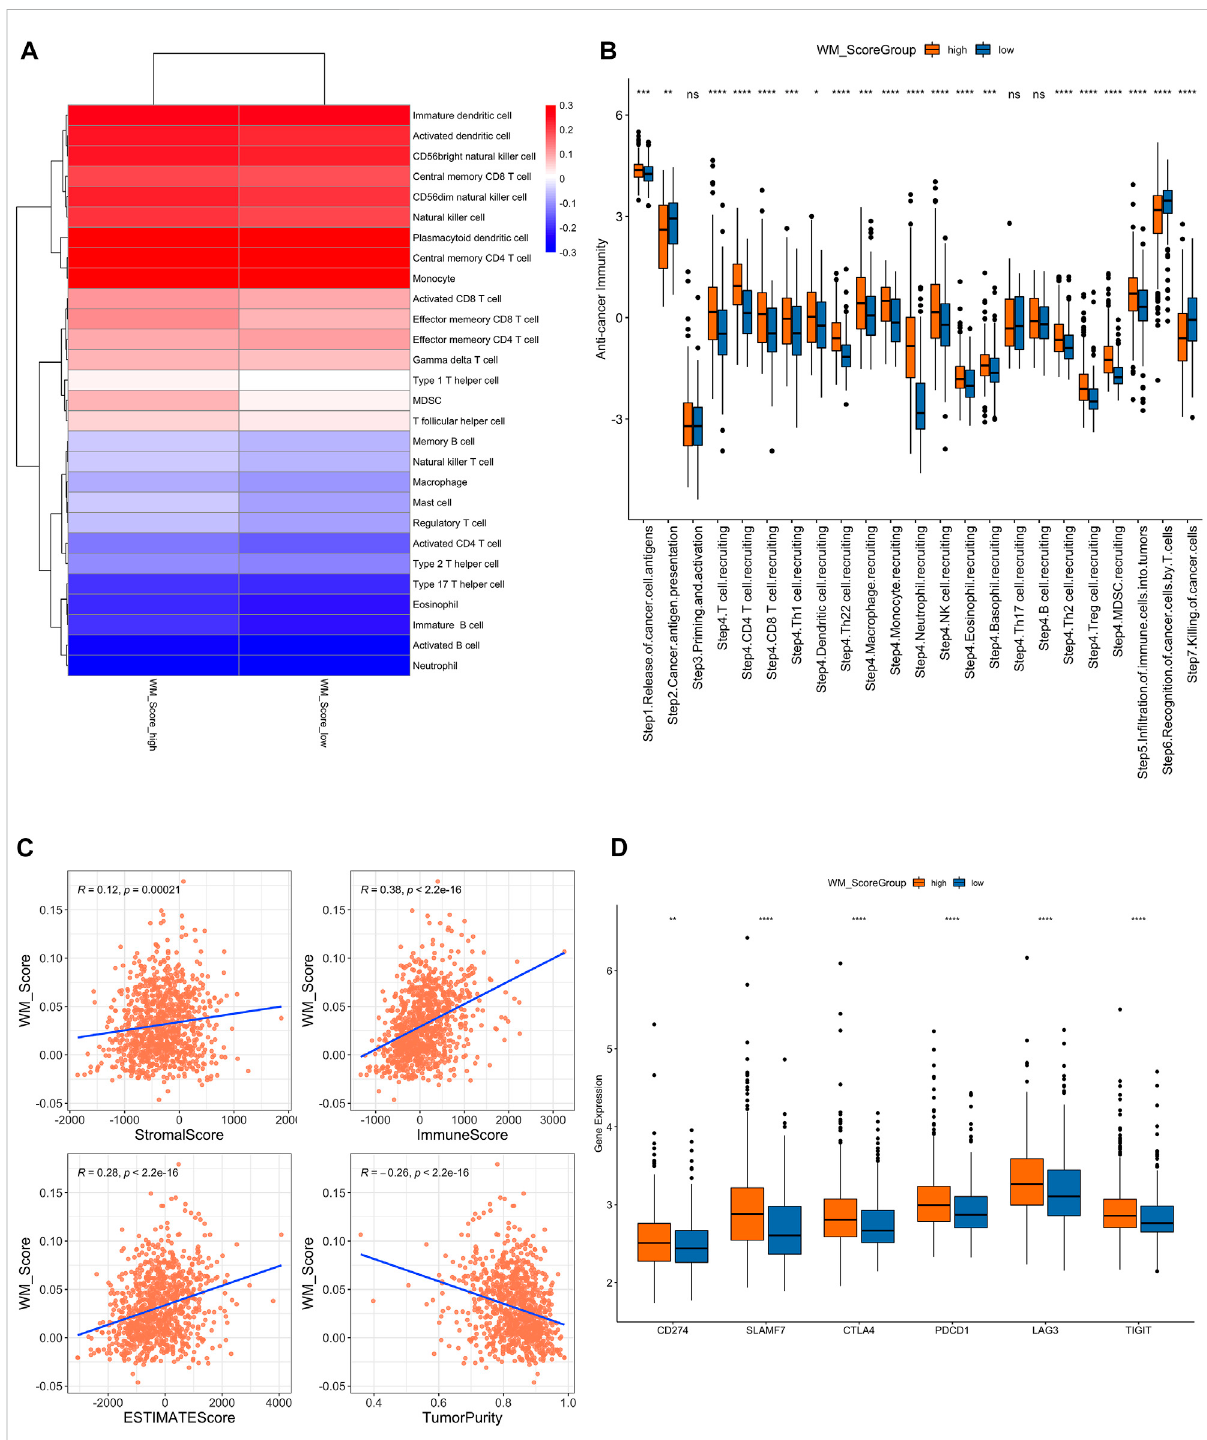
FIGURE 5 (A) . Difference of immune cell in fi ltration in the WM_Score-high/-low. (B) Analysis of the difference in anti-tumor immune process activity between high and low risk groups with WM_Score scores. (C) Correlation of WM_Score scores with stromal score, immune score, and tumor purity (A: stromal score; (B) immune score; (C) estimate score; (D) tumor purity) by Spearman analysis. (D) Gene expression of immune checkpoint expression in WM_Score -high and